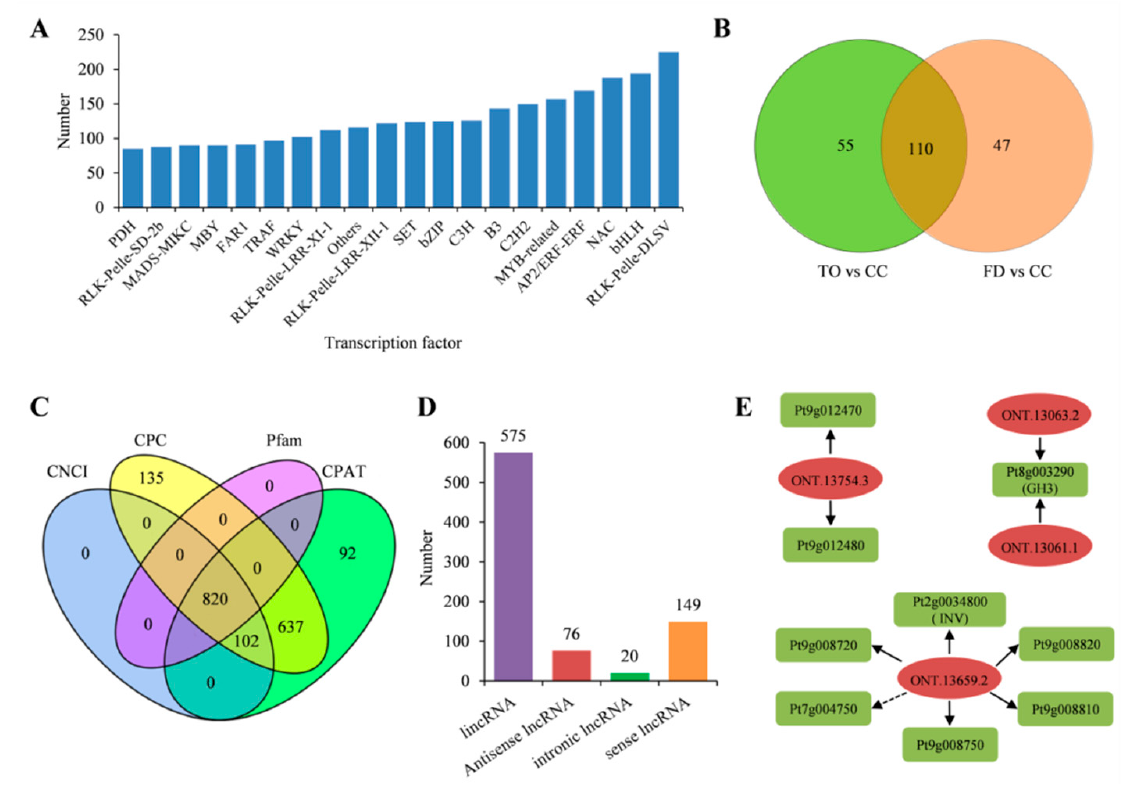
Figure 7. Identification of TFs and lncRNAs based on the full-length transcriptome. ( A ): Numbers of the top 20 TF families identified in all full-length transcripts. ( B ): Venn diagram shows the overlapped in the differential expressed FTs among the three rootstocks. ( C ): Venn diagrams show the number of lncRNAs identified using four different public databases. ( D ): Number of four lncRNA types. ( E ): Examples of predicted interaction networks among lncRNAs and their target genes. Solid lines and dotted lines indicate the expression regulation by the lncRNAs in cis and trans, respectively.